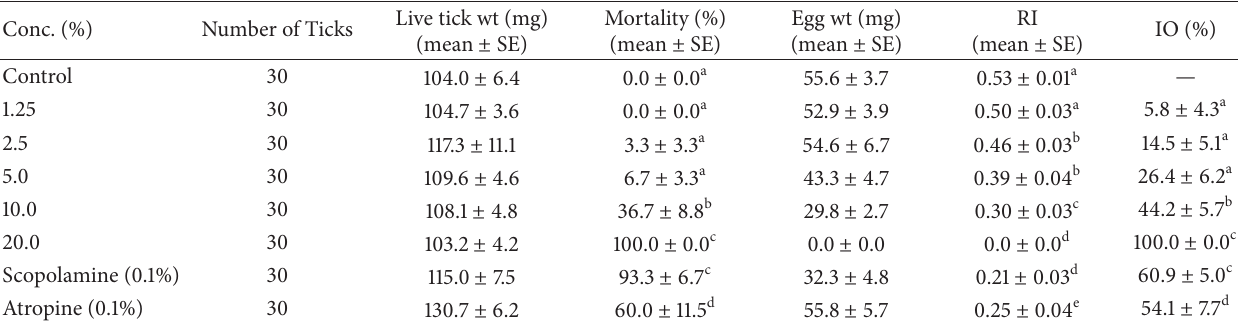
Table 1: Tick weight, percent mortality, egg weight, reproductive index (RI), and inhibition of oviposition (IO) of R . ( B .) microplus adults exposed to different concentrations of methanolic extract of Atropa belladonna and its constituents, scopolamine and atropine. Conc. (%)